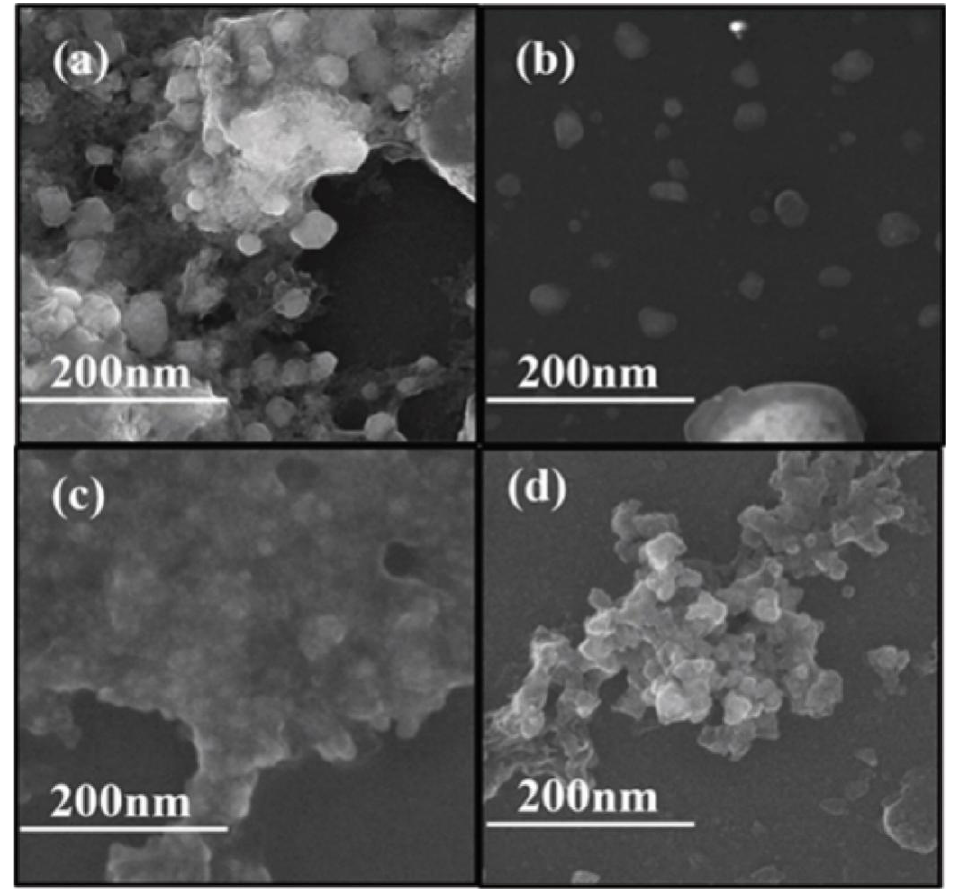
Figure 2. FESEM of green synthesized Ag-NPs using plant extracts of ( a ) Aloe vera , ( b ) lemongrass, ( c ) mint, ( d )